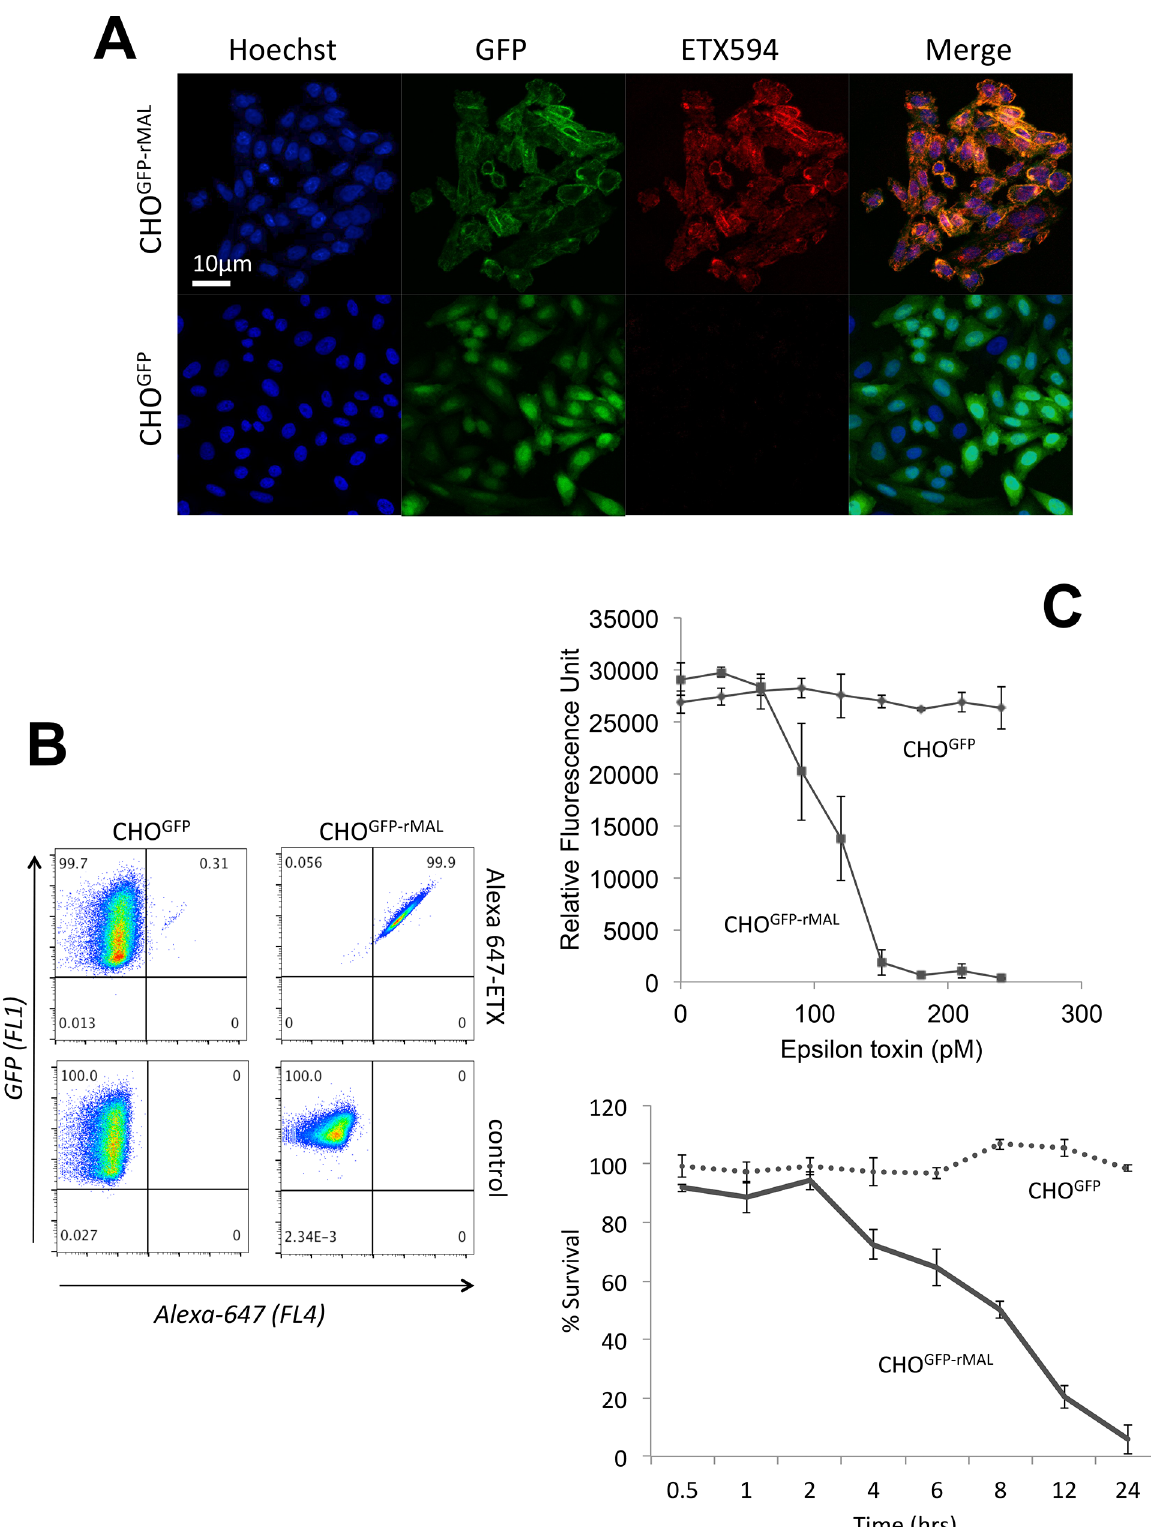
Fig 1. MAL expression in CHO cells is required to confer specific binding of ETX. Stable clones of CHO cells expressing either GFP (CHO GFP ) or GFP- rMAL (CHO GFP-rMAL ) were assessed for binding with Alexa-594 labeled ETX (ETX594). ( A ) Confocal images of fixed CHO GFP or CHO GFP-MAL cells